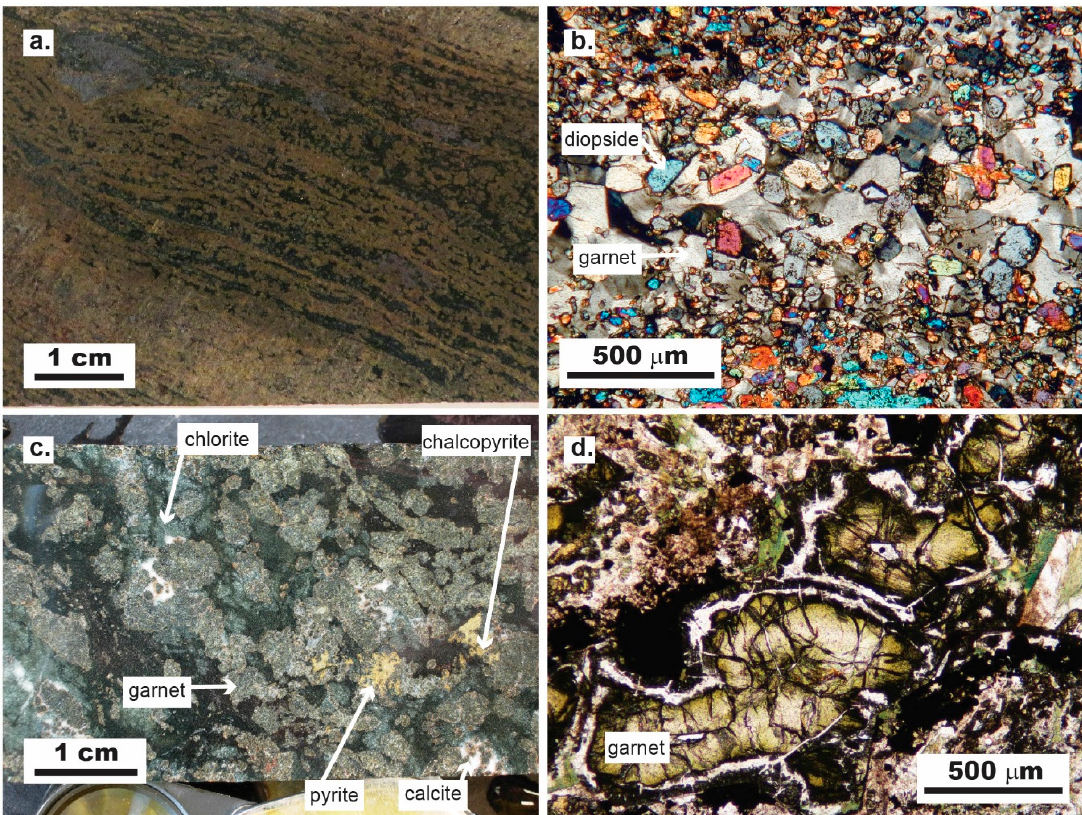
Figure 8. Examples of skarn alteration assemblages from the Olympic Cu-Au Province. ( a ) Typical fine to medium grained banded skarn alteration. Drill hole HODD3, 1094 m. ( b ) Thin section scale view of banded skarn showing garnet (light grey to black) intergrown with pyroxene (diopside). Sample 1,709,149, drill hole PD DD2, 991.1 m. ( c ) Example of coarse grained, retrograde skarn assemblage comprising garnet, pyroxene, calcite, chlorite and amphibole (dark green zones). Note pyrite and chalcopyrite in this phase of skarn alteration. ( d ) Thin section view of retrograde skarn showing green coloured, compositionally zoned andradite garnet intergrown with white calcite and dark hematite. Green mineral is chlorite and matrix contains very fine grained quartz-sericite-hematite intergrowth. Sample 1,833,364, drill hole DDH AD8, 861 m.